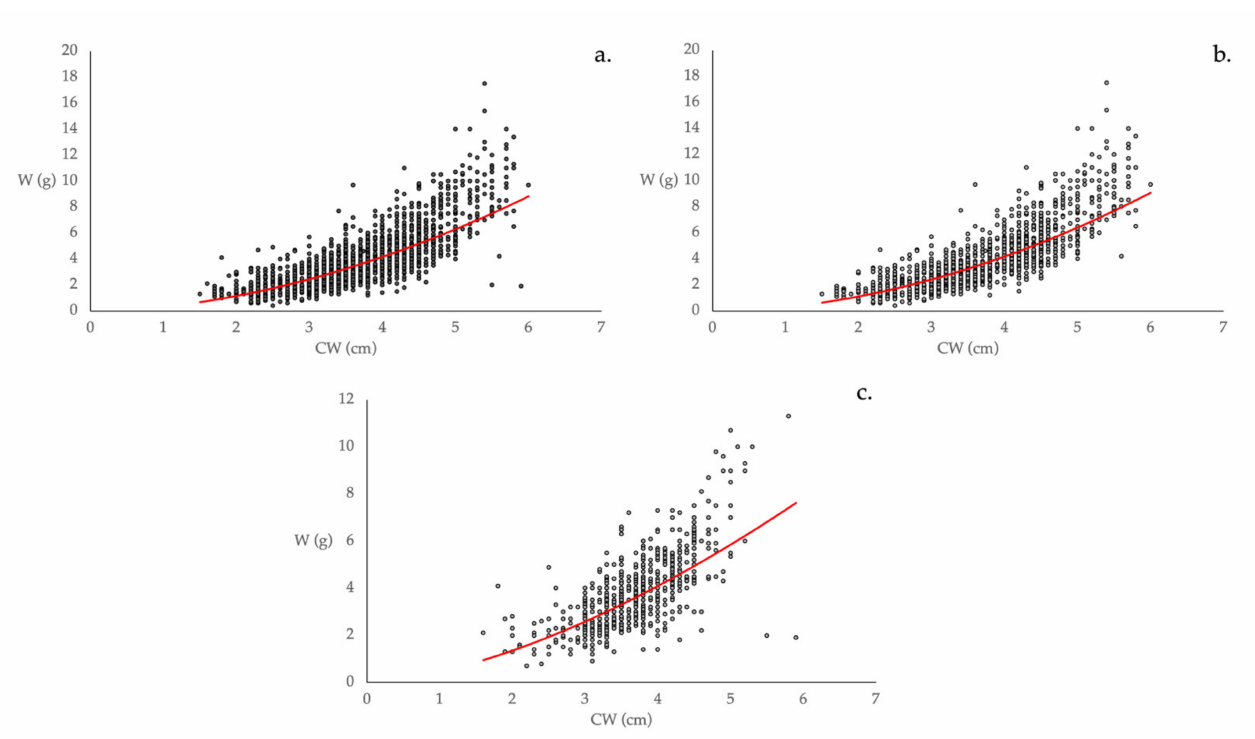
Figure 3. Scatter plot of points corresponding to the CW (carapace width) and W (weight) ratio, for Achelous spinicarpus . ( a ) total number of crabs, ( b ) males and ( c ) females.